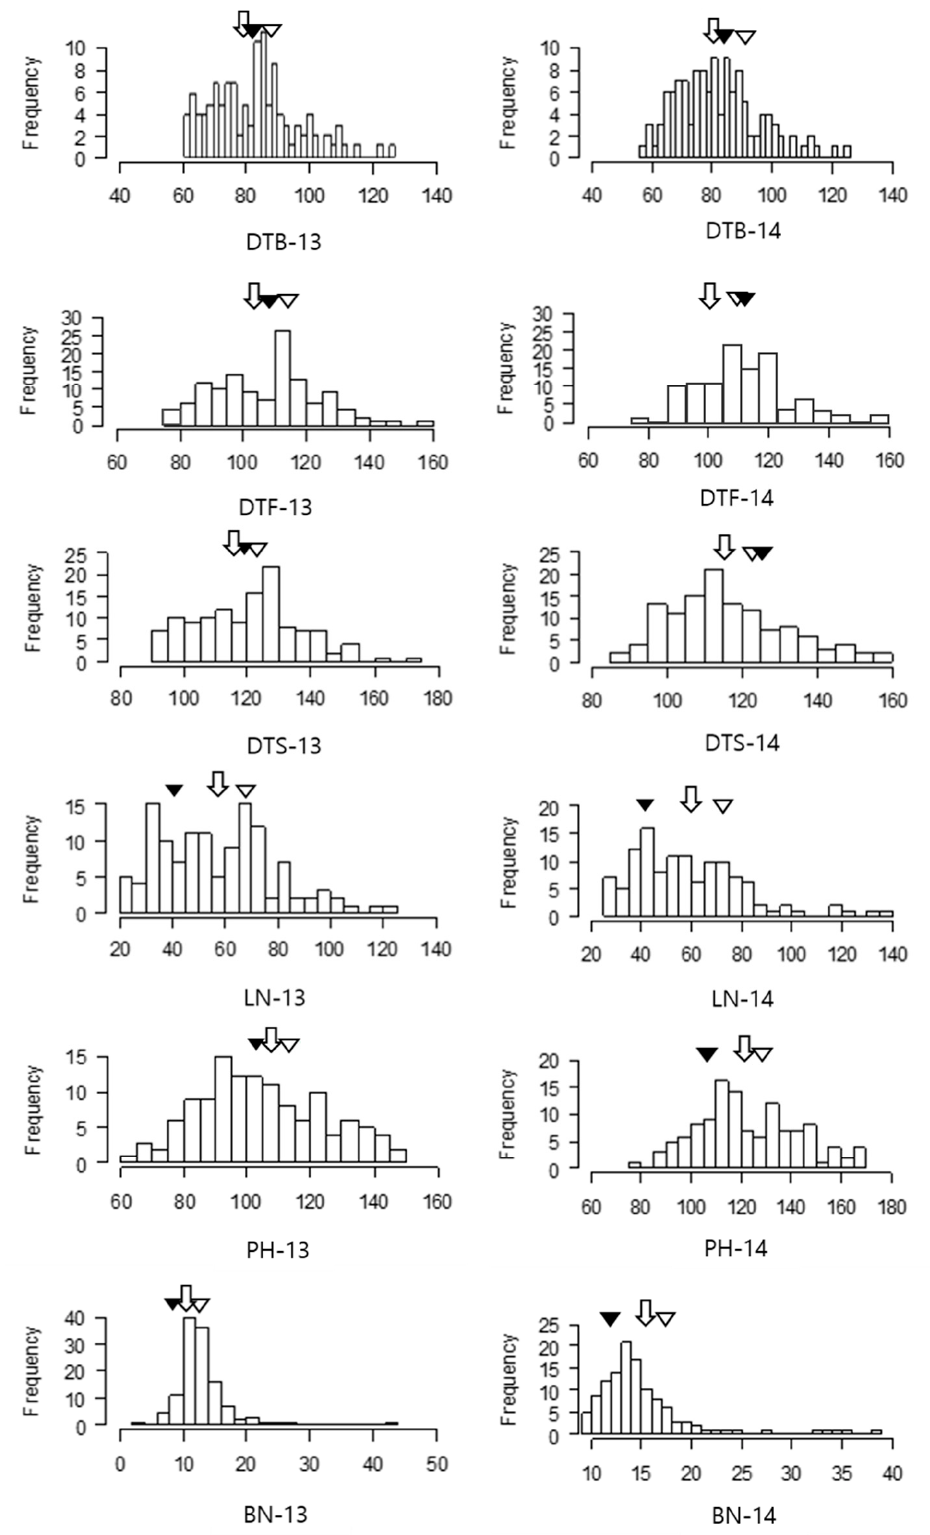
Figure 1. Frequency distribution for each trait in the F5 RIL population. The suffix “-13” refers to the spring trial conducted in 2013, while “-14” refers to the spring trial in 2014. Means for the parental and F5 RIL population are shown by arrows. ( ▽ ) Lactuca sativa L. cv. Chimasanchu (n = 10); ( ▼ ) Lactuca sativa L. cv. Banchu Red Fire ( n = 10); ( ) F5 ( n = 127).